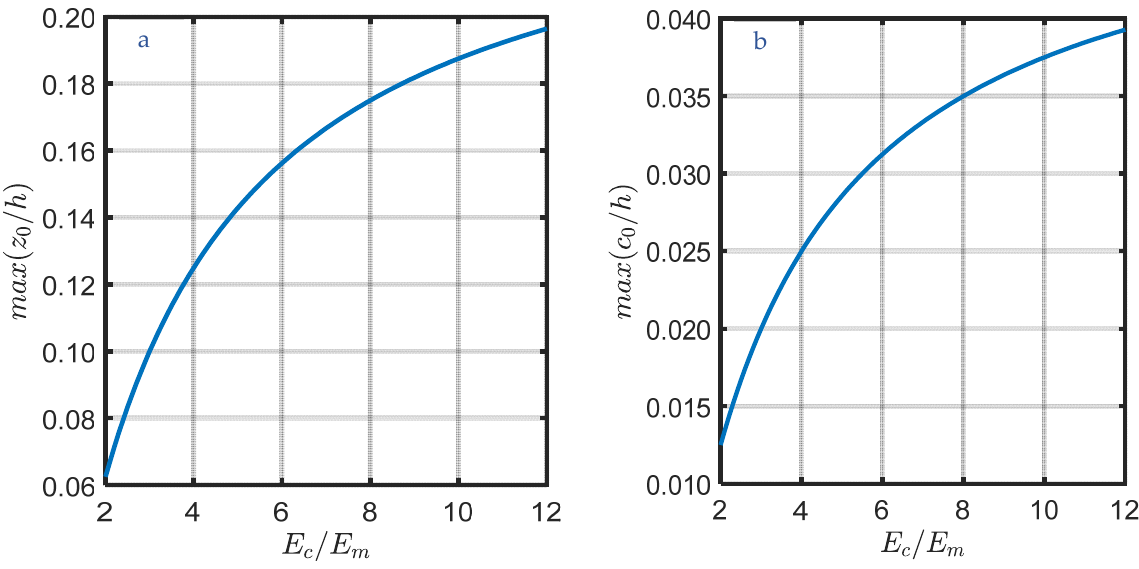
Figure 3. Maximum values of ( a ) z 0 / h and ( b ) c 0 / h at different E c / E m ratios at ( n z = 2, n x = 1 ) .